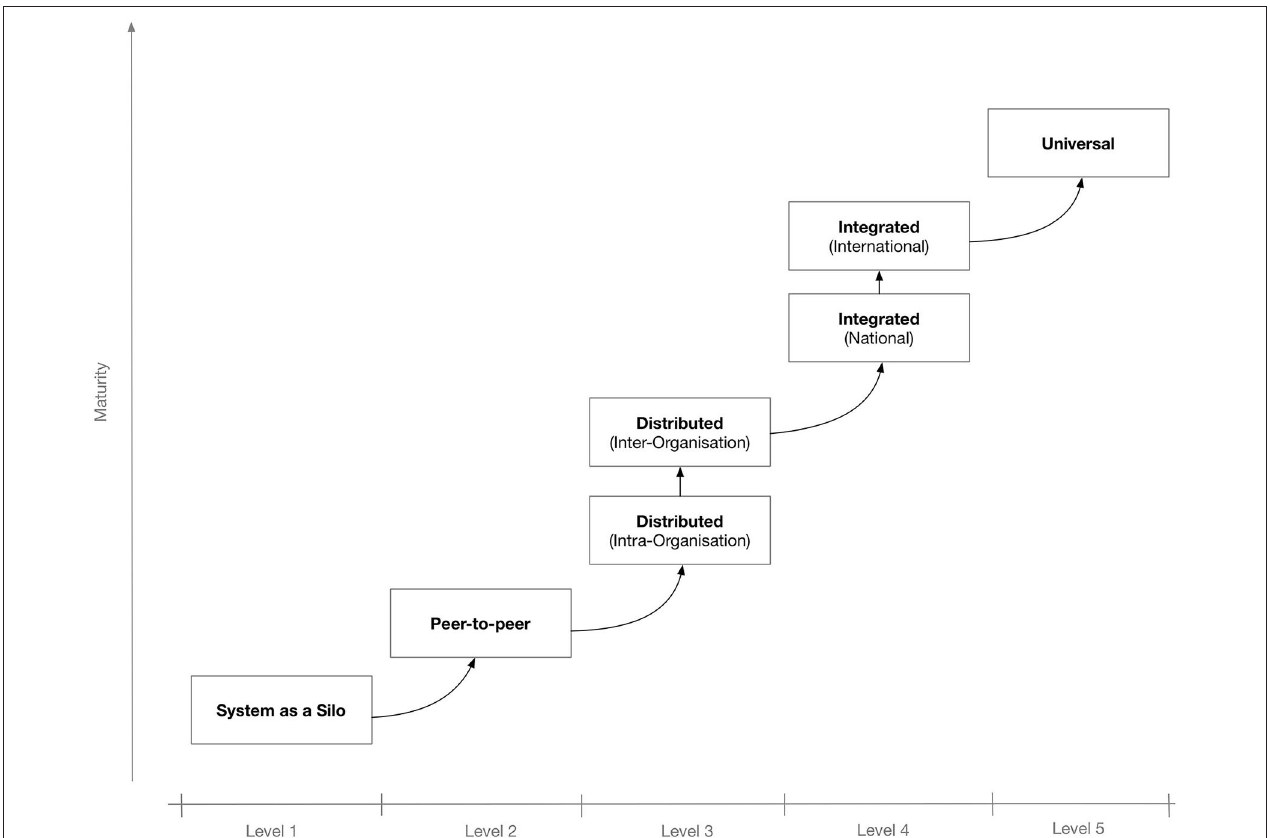
FIGURE 1 | A maturity model for interoperability in eHealth [adapted from